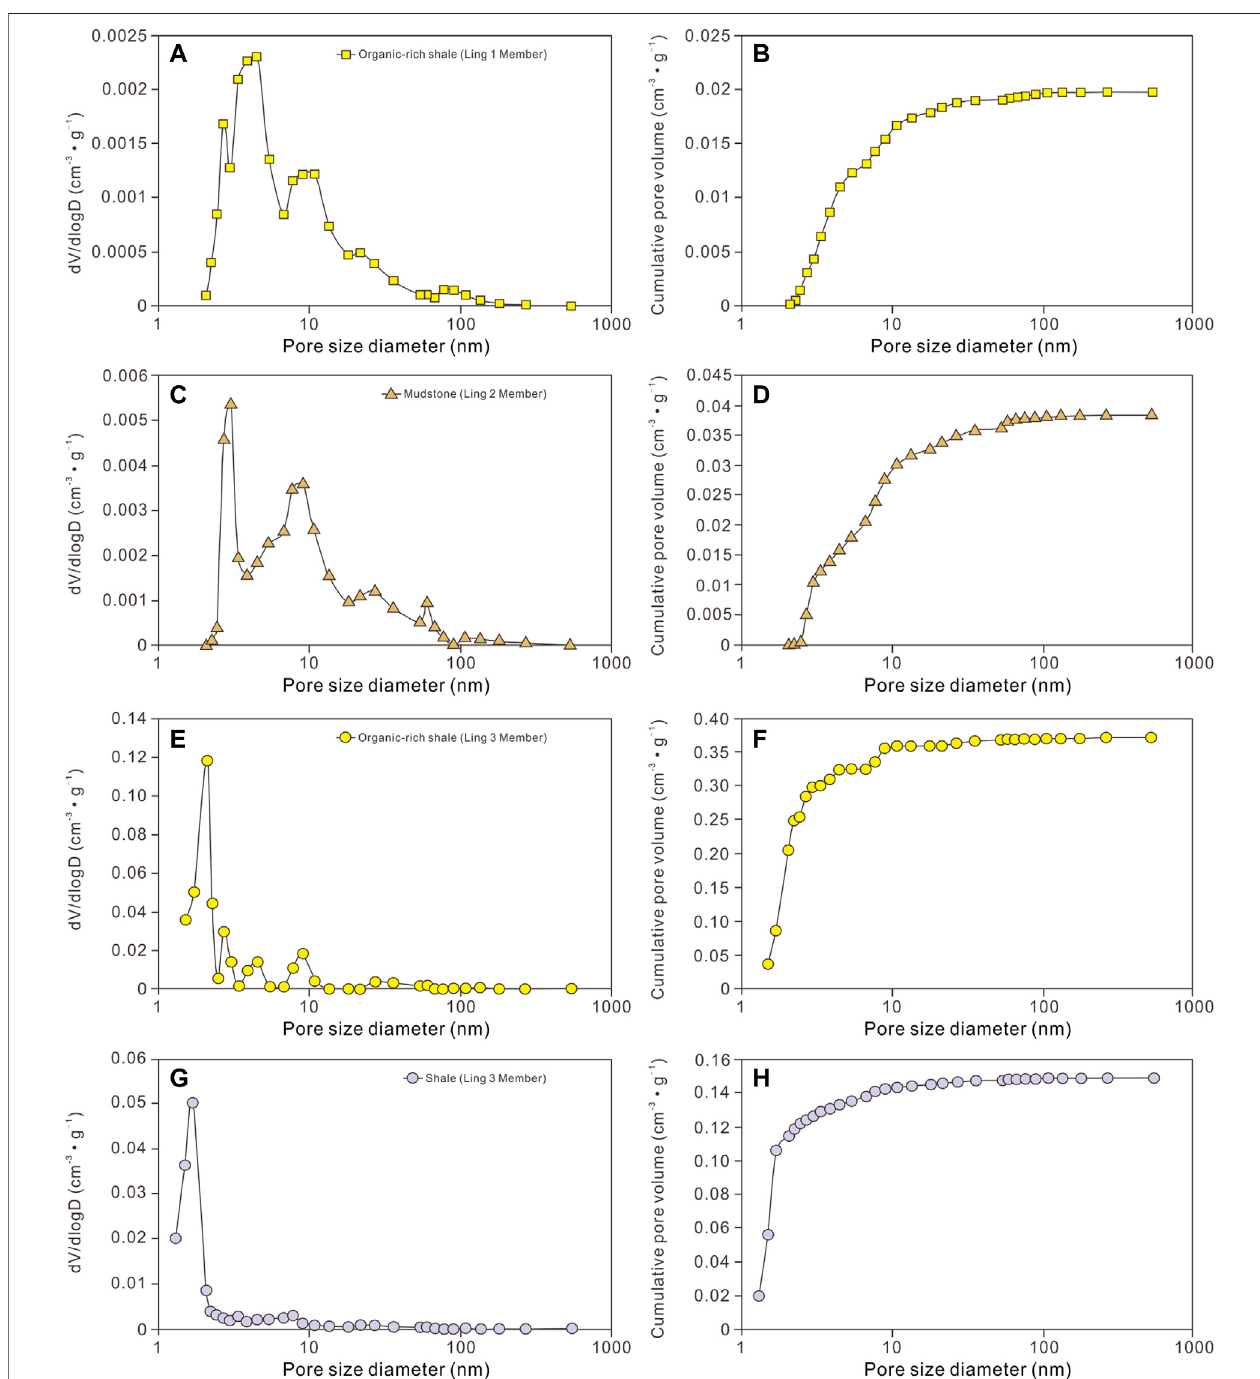
FIGURE 7 | NMR cryoporometry pore size distribution curves for the Upper Permian Linghao Formation shale/mudstone from the studied well in Nanpanjiang Basin. (A) Ling 1 member organic-rich shale, 3,772.05 m. (B) Ling 1 member organic-rich shale, 3,772.05 m. (C) Ling 2 member mudstone, 3,556.80 m. (D) Ling 2 member mudstone, 3,556.80 m. (E) Ling 3 member organic-rich shale, 3,407.00 m. (F) Ling 3 member organic-rich shale, 3,407.00 m. (G) Ling 3 member shale, 3,410.50 m. (H) Ling 3 member shale, 3,410.50 m.